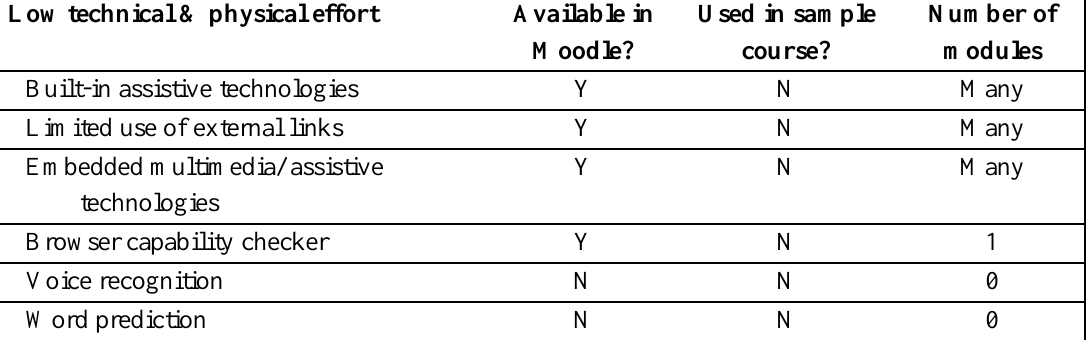
Used in sample Number of Moodle? course? modules Y N